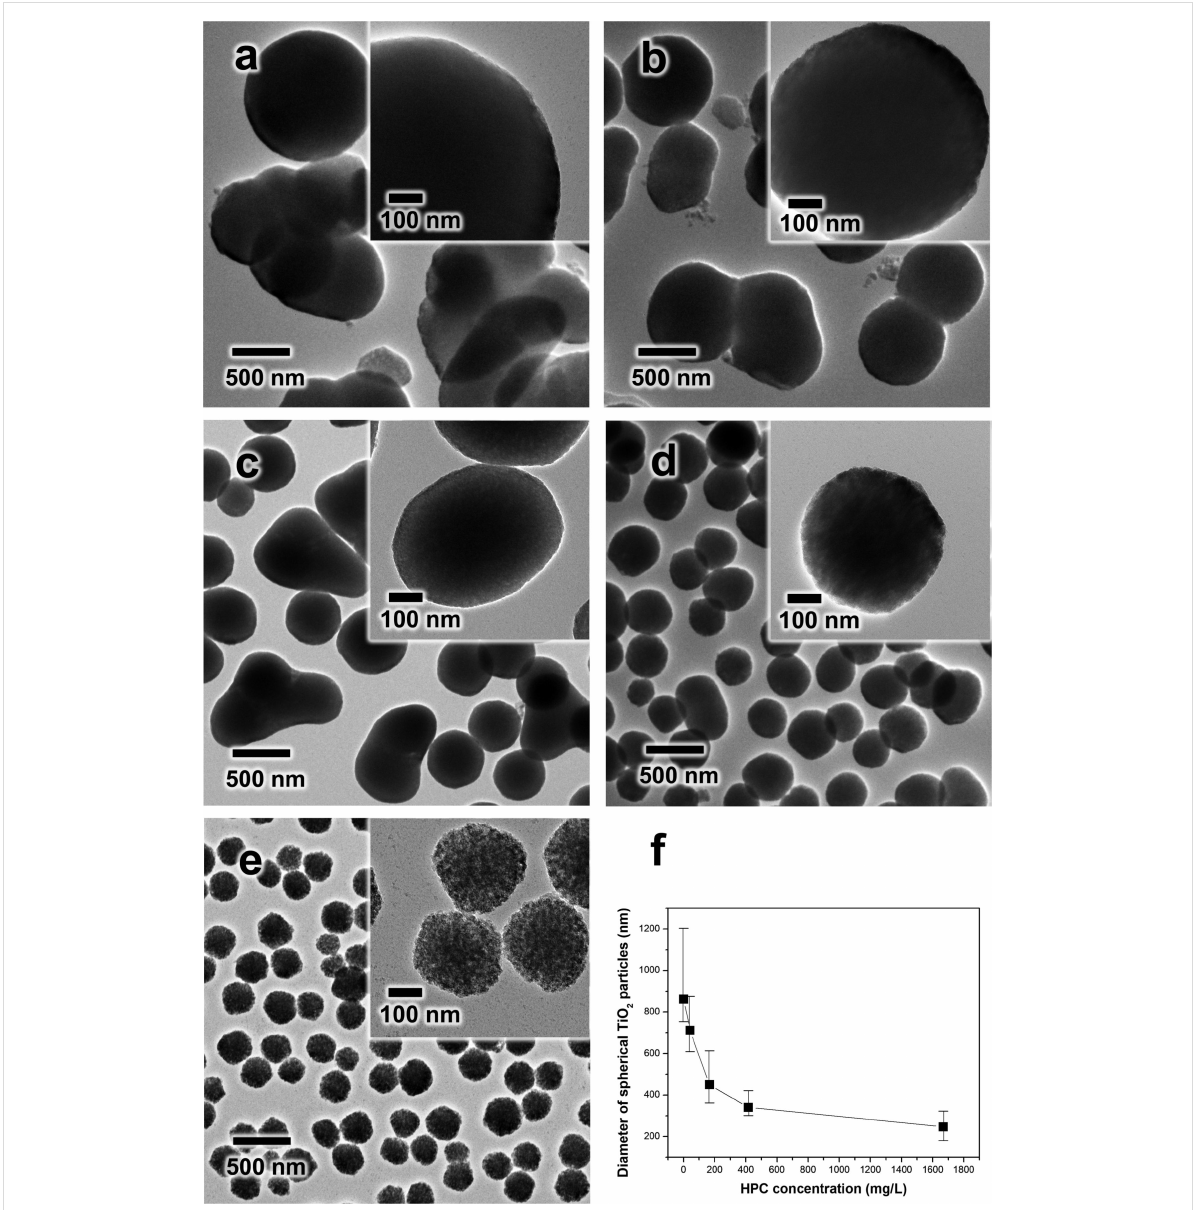
Figure 2: (a–e) TEM images of as-synthesized TiO 2 with different concentrations of HPC: (a) 0 (b) 41.67 (c) 166.67 (d) 416.67 and (e) 1666.67 mg/L. (f) The relationship between HPC concetnration and average diameter of spherical TiO 2 particles.